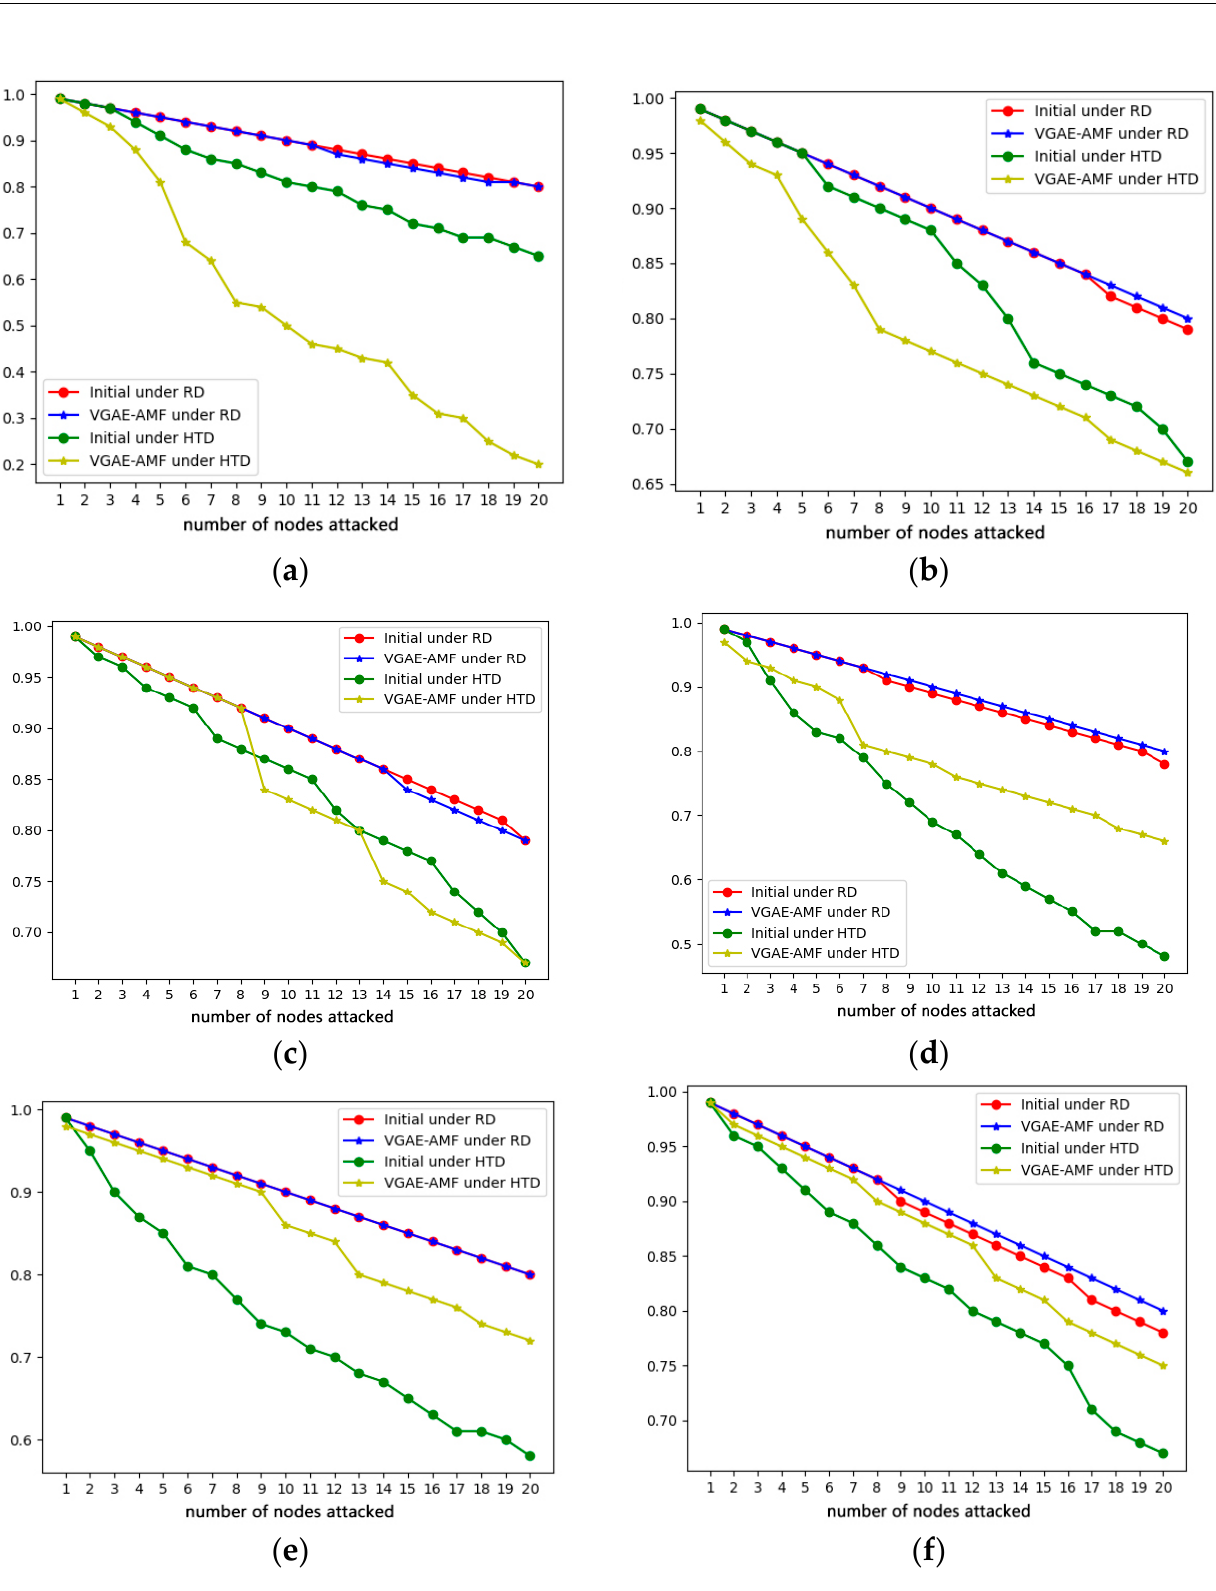
Figure 9. Effect of different values